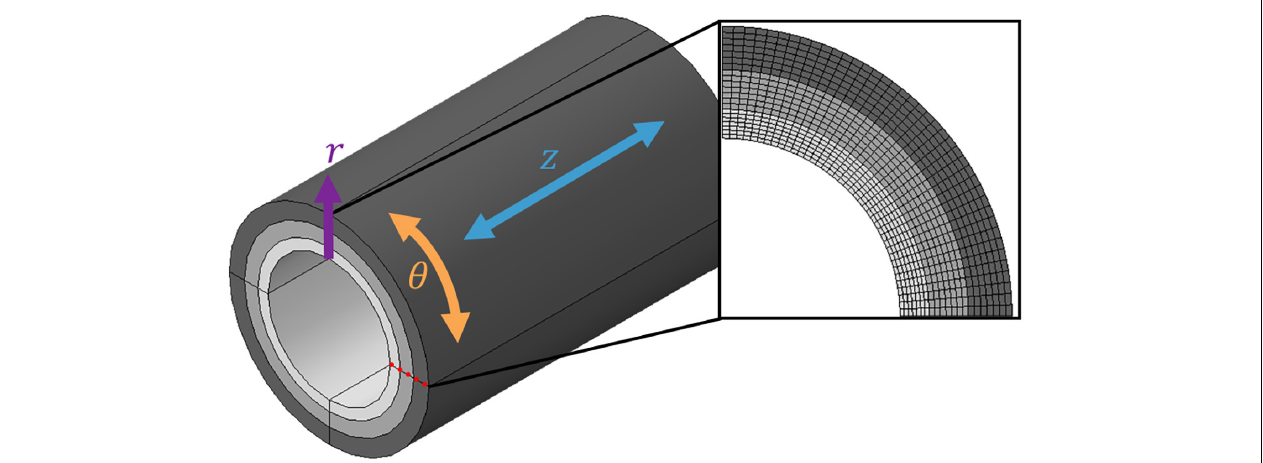
FIGURE 2 | Discretised three-layer coronary artery wall. A cylindrical coordinate system was adopted using the three-dimensional coordinates r (radial), θ (circumferential) and z (axial). Each layer was meshed with seven layers of elements through the radial thickness; the nodal analysis path used to extract field variable values from the model is highlighted by the red dotted